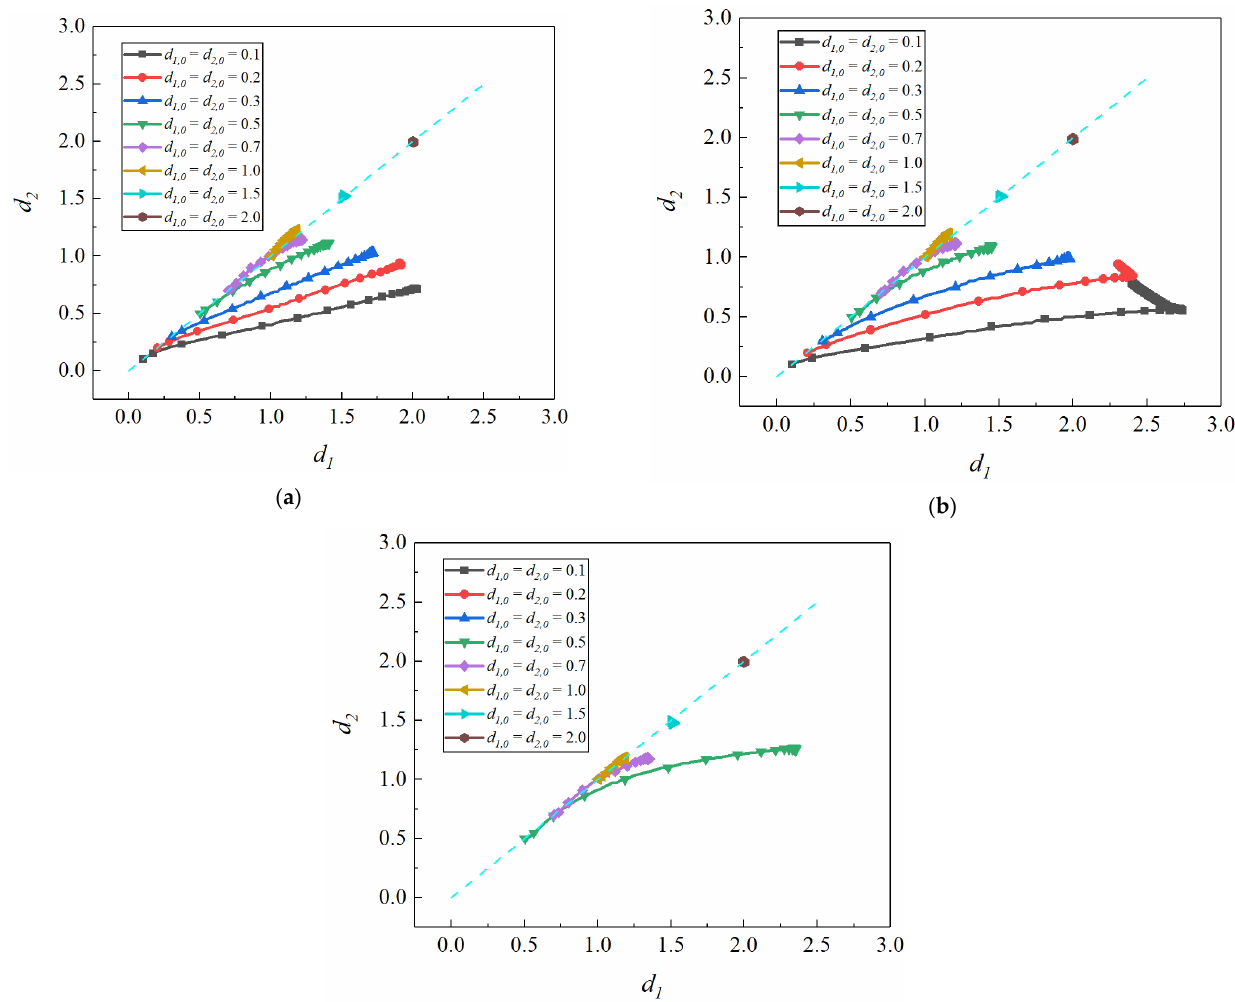
Figure 12. Diverse variation of interparticle distances for different initial confinement ratios. ( Wi = 0.5, η r = 0.3, α = 0.1, y 0 = 0.2). ( a ) ε = 0.2; ( b ) ε = 0.3; ( c ) ε = 0.4.